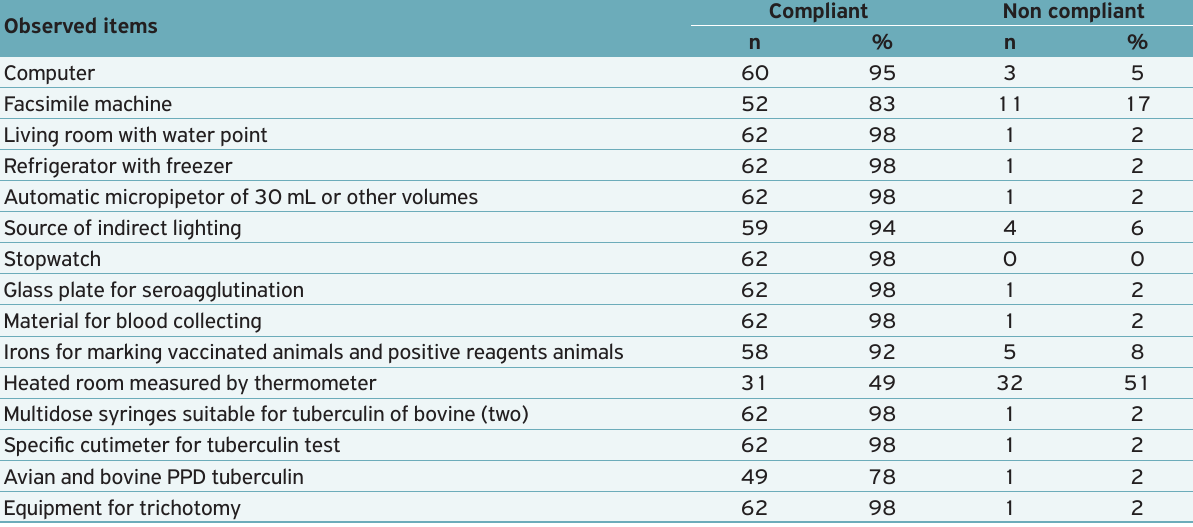
Compliant: Regular status at the Institute of Agricultural and Forestry Defense of the Espírito Santo (IDAF), based on the Normative Instruction n o 30 of 2006 and the Technical Manual of PNCEBT (Brazil, 2006a; 2006b); Non compliant: Irregular situation in IDAF; CRMV-ES: Regional Council of Veterinary Medicine of Espírito Santo. Table 2. Infrastructure available to veterinarians qualified to serve on the National Programme for Control and Eradication of Animal Brucellosis and Tuberculosis according to the records of supervision applied by the Institute of Agricultural and Forestry Defense of Espírito Santo state, Brazil, between 2008 and 2011.